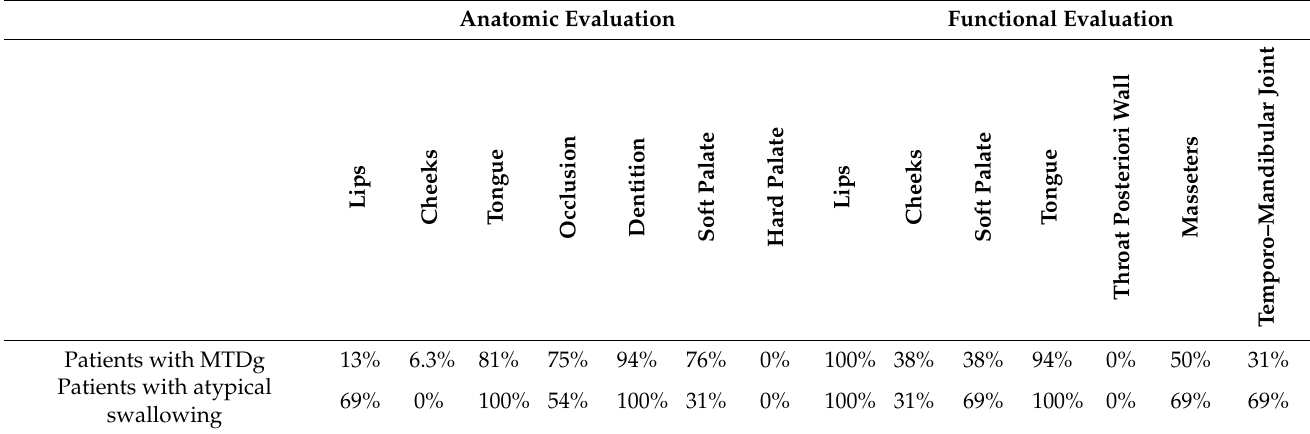
Table 2. Percentage of patients with abnormalities in logopaedic